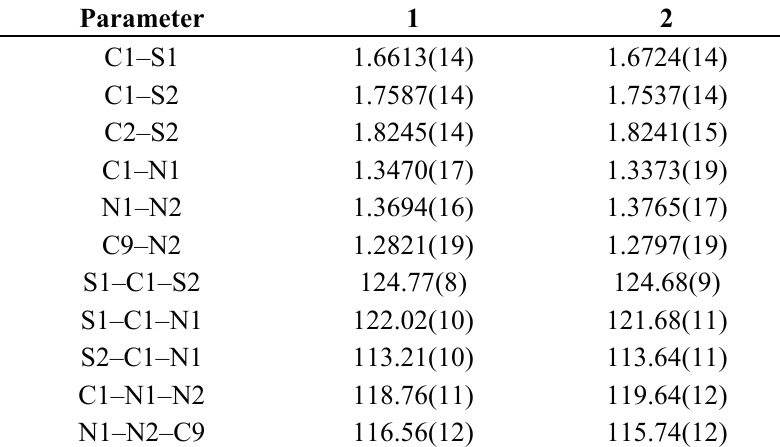
Figure 1. The molecular structure of 1 showing the atom-labeling scheme and 70% displacement ellipsoids. Table 4. Selected geometric parameters (Å, °) for 1 and 2